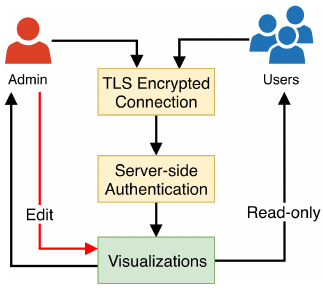
Figure 3. Web-interface security.